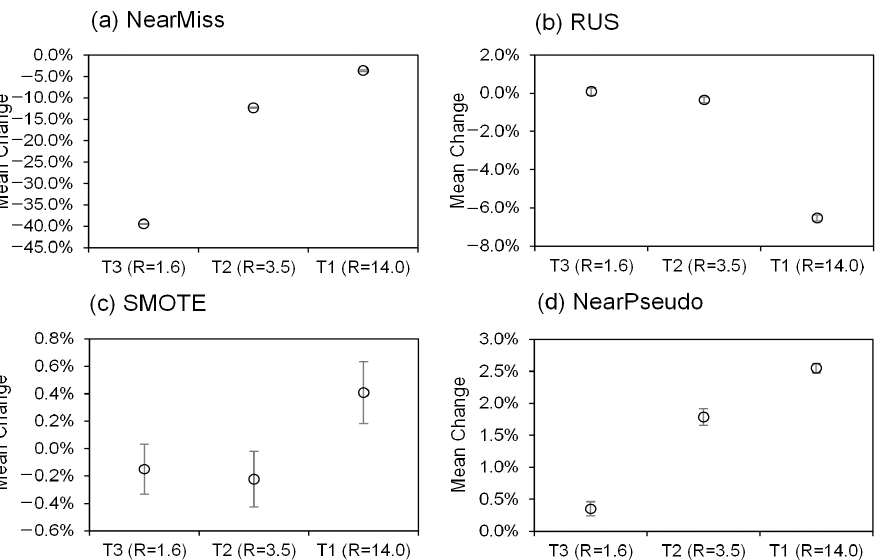
Figure 2. Mean change in overall accuracy from baseline (unbalanced dataset) to balanced dataset after processing on the three sub-training sets. T1 , T2 , and T3 represent datasets with different degrees of imbalance. T1 represents an extremely imbalanced training dataset with R (Max/Min) = 14.0, T2 represents a relatively imbalanced training dataset with R (Max/Min) = 3.5, and T3 represents a slightly imbalanced training dataset with R (Max/Min) = 1.6. All data are mean ± standard error from five